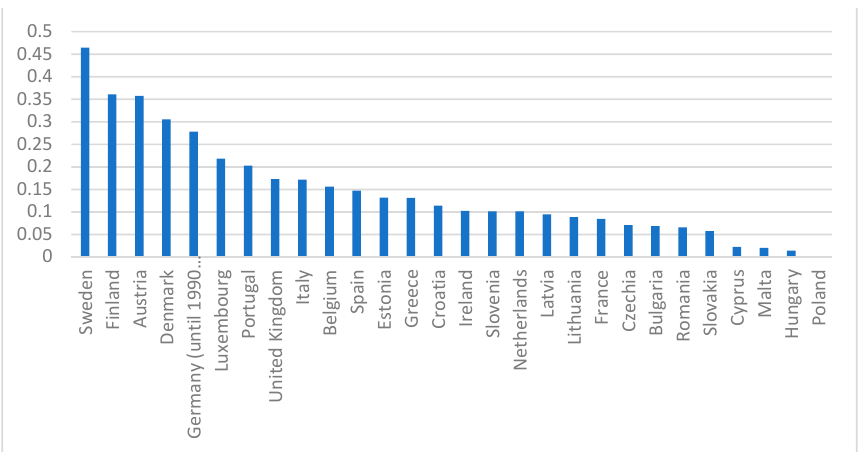
Figure 3. Development taxonomic ratio values (RMT) for the examined countries in 2014. Source: author’s own elaboration.